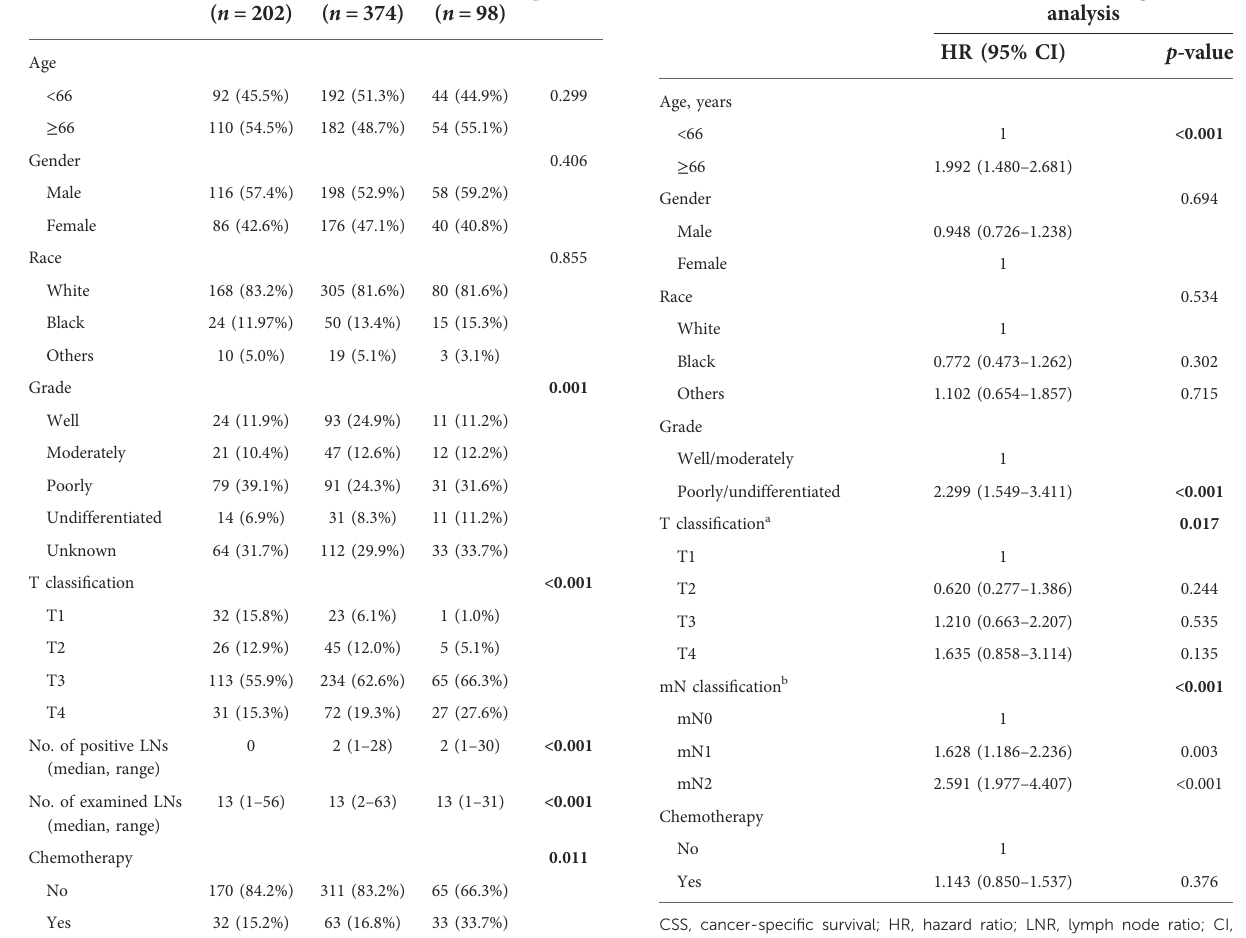
TABLE 3 Multivariate Cox regression analysis of predictors of CSS based on revised T/mN classi fi cation. Characteristic Multivariate Cox regression